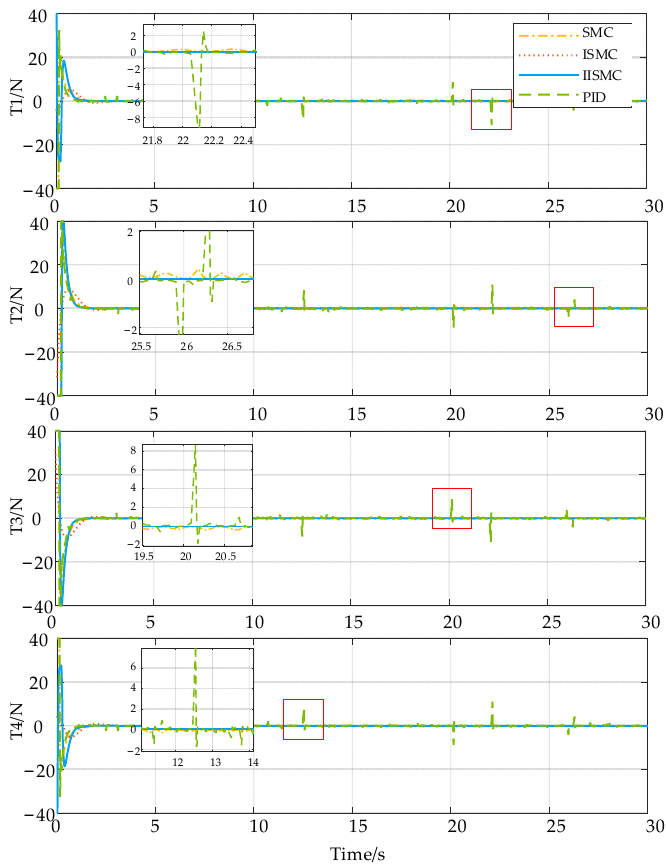
Figure 9. The thrust curve of four heave thrusters in Scene 1.